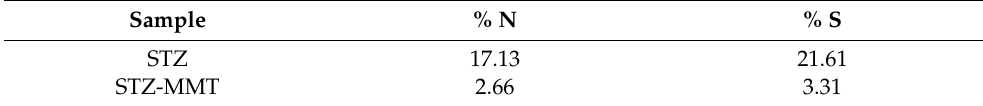
Figure 6. SEM microphotographs of STZ ( A – B ), MMT ( C ) and STZ-MMT ( D – F ). Table 1. Elemental analysis of STZ and STZ-MMT